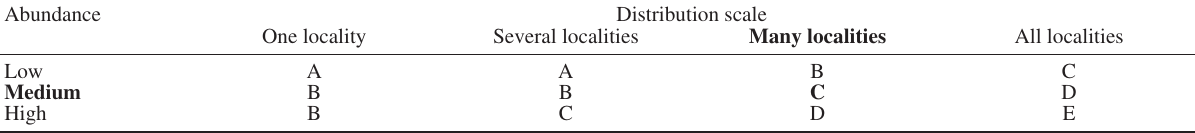
should obtain level “C” (see text).